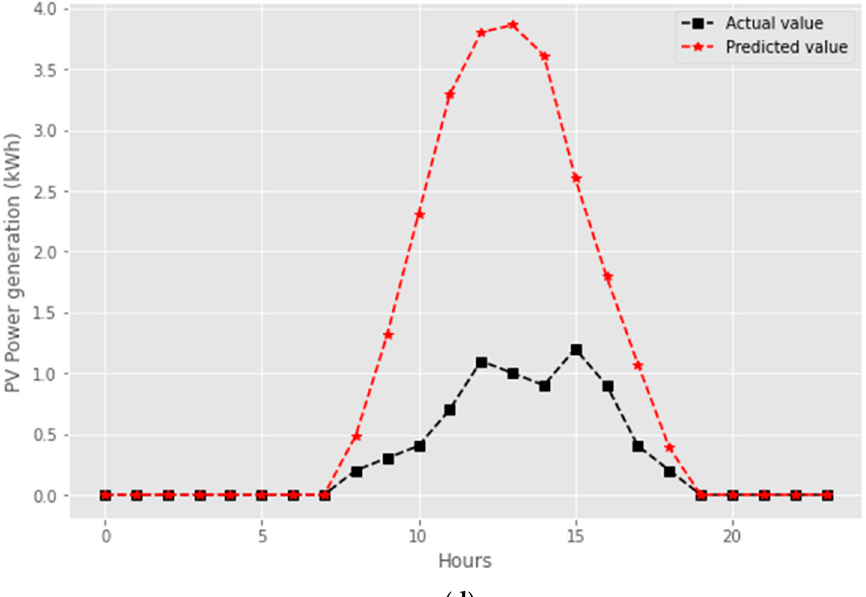
Figure 10. Forecasting results according to the uncertainty of historical and future data: ( a ) historical and future data for 10 March 2020; ( b ) forecasting result on 10 March 2020; ( c ) historical and future data on 27 March 2020; ( d ) forecasting result for 27 March 2020 .